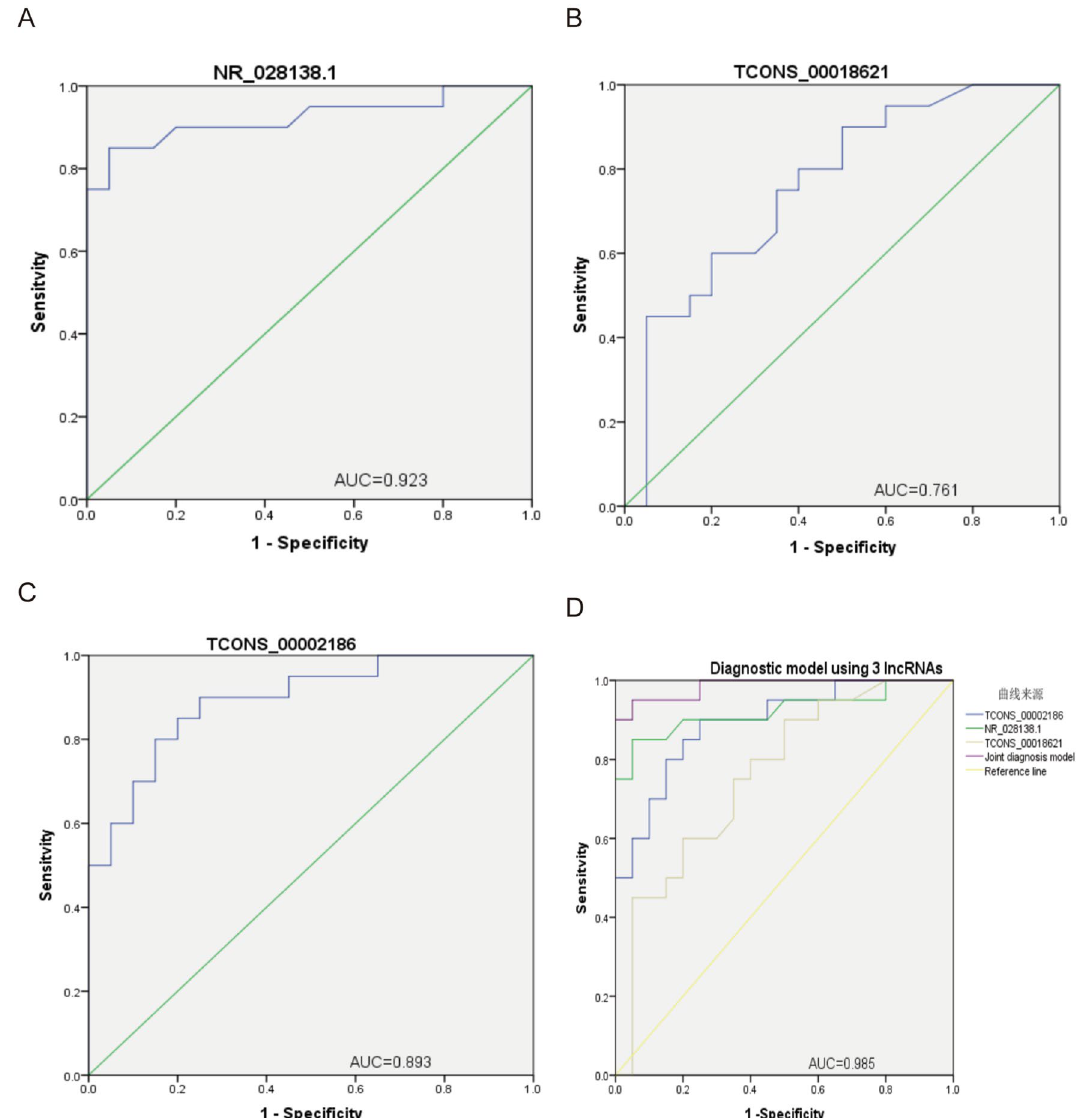
Figure 6. Diagnostic power of the three lncRNA candidates evaluated using receiver operating characteristic (ROC) curves. ( A ) NR_028138.1, ( B ) TCONS_00018621, and ( C ) TCONS_00002186. ( D ) Diagnostic model using 3 lncRNAs. Optimal diagnostic points were considered cutoff values with the largest Youden’s index (sensitivity + specificity –